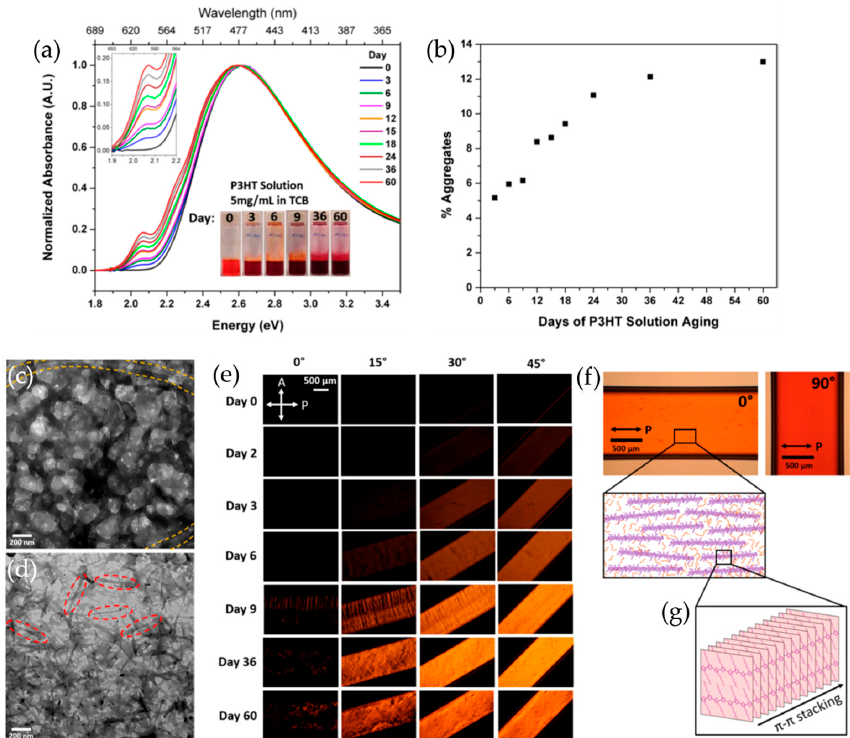
Figure 2. ( a ) Solution UV-vis spectra; and ( b ) percent aggregates of P3HT/1,2,4-trichlorobenzene (TCB) solution as a function of time; Cryo-transmission electron microscopy (TEM) images of P3HT solutions in TCB aged for: ( c ) 0 and ( d ) 31 days. ( e ) Polarized optical microscopy (POM) images of capillaries filled with P3HT/TCB solutions aged for a range of times, rotated in increments of 15° between crossed polarizers. ( f ) Change in absorption of a capillary filled with a P3HT/TCB solution aged for 36 days as a function of capillary orientation with respect to polarizer. ( g ) Schematic representation of P3HT nanofibers aligned along the capillary long axis. Reproduced with permission from [60]. Copyright 2015 American Chemical Society.